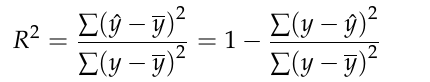
Table 5. Assignment of values for a 10-point scale [58].